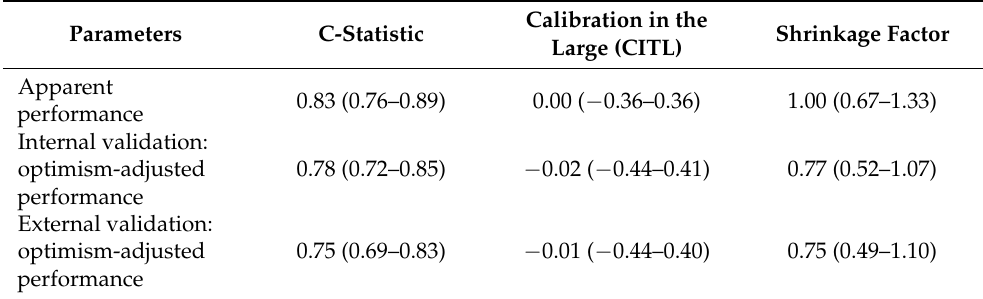
Figure 6. Probability of fail of non-operative reduction of intussusception by predicted model stratified by failed vs. successful reduction in the development and the validation sets. Table 7. Internal and external validation model calibration parameters with 1000 replications boot- strapping method (95% confidence